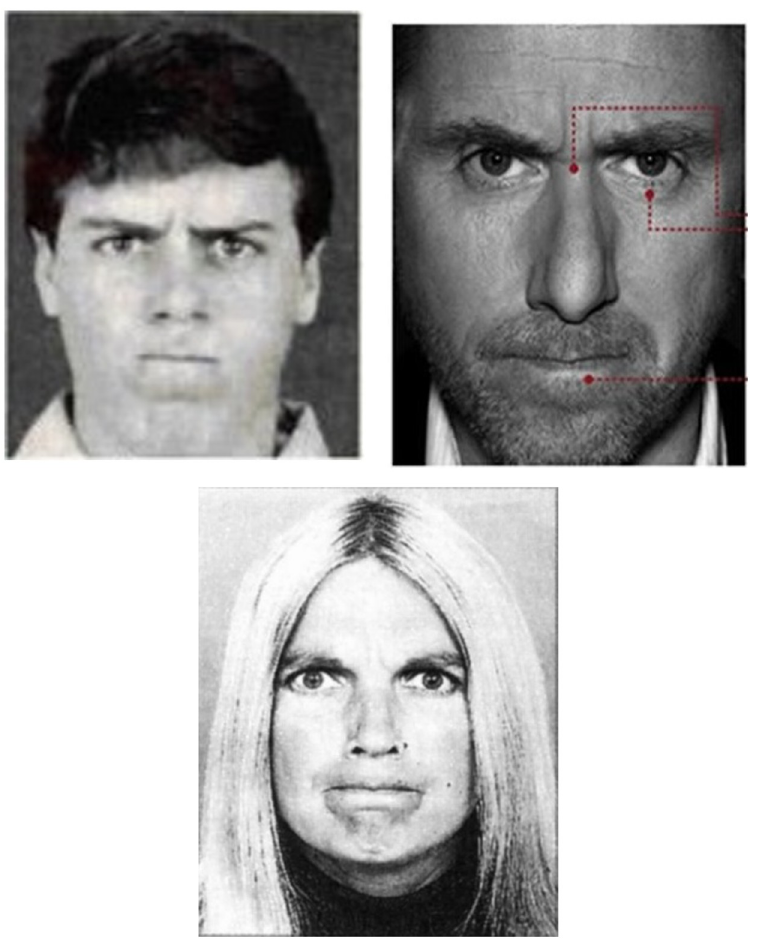
Fig 2. Reference pictures for anger. All other reference images can be seen in the supplementary material (S1